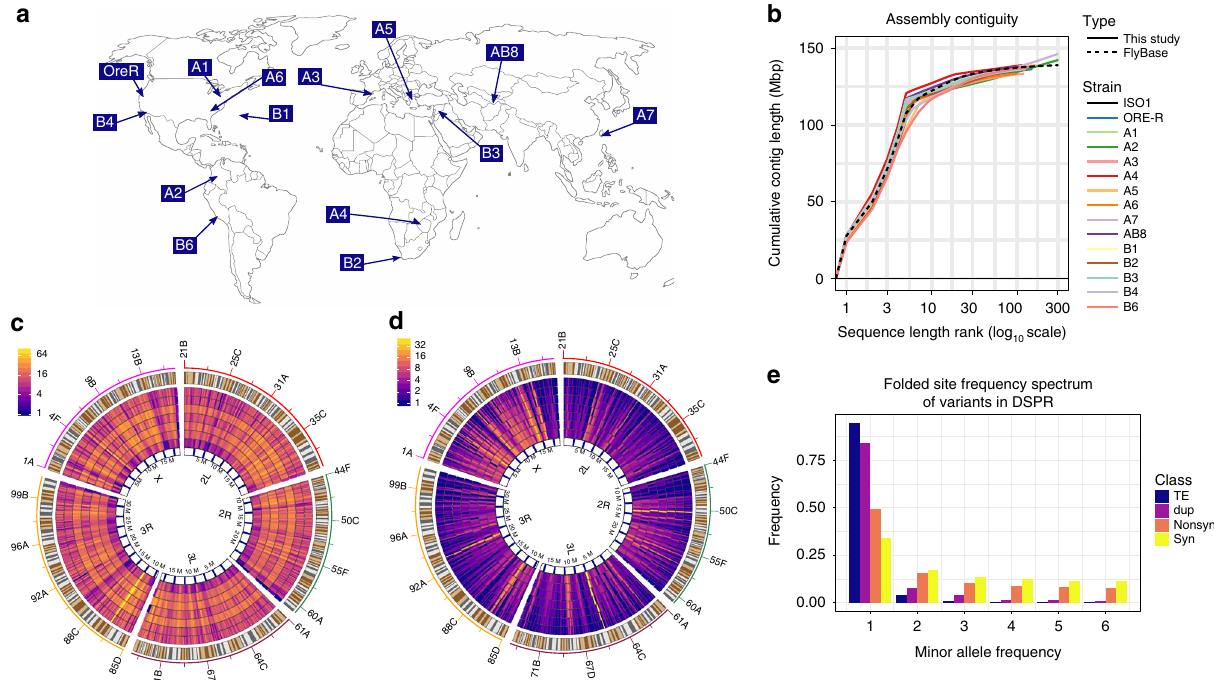
Fig. 1 SVs in fourteen geographically diverse D. melanogaster strains. a Geographic locations of the sequenced strains of D. melanogaster (map source: www. outline-world-map.com). As shown here, the founder strains from DSPR and Oregon-R originate from diverse worldwide populations. b Cumulative contiguity plot showing comparison of assembly contiguity between the reference strain ISO1 and our 14 assemblies. c Distribution of euchromatic TE insertions across the major chromosome arms. The outermost track represents the chromosome ideogram, showing the locations of named bands. Each subsequent inner track shows distributions of TE insertions per genomic window of fi xed size, ranging from 100 – 400kb in 50 kb increments. Details of the TE rich region (yellow streak) on 3R (87B;12.47 – 12.5 Mb) is shown in Supplementary Fig. 4. d Distribution of duplication CNVs within euchromatin of major chromosome arms. The outermost track represents ideogram as in c . Inner tracks represent distributions of duplication CNVs in windows of varying sizes as in c . Unlike TEs, distribution of duplications are less uniform within and between the chromosomes. e Counts of minor allele frequency for TE, duplicated sequences (dup), nonsynonymous SNPs (Nonsyn), and synonymous SNPs (Syn)